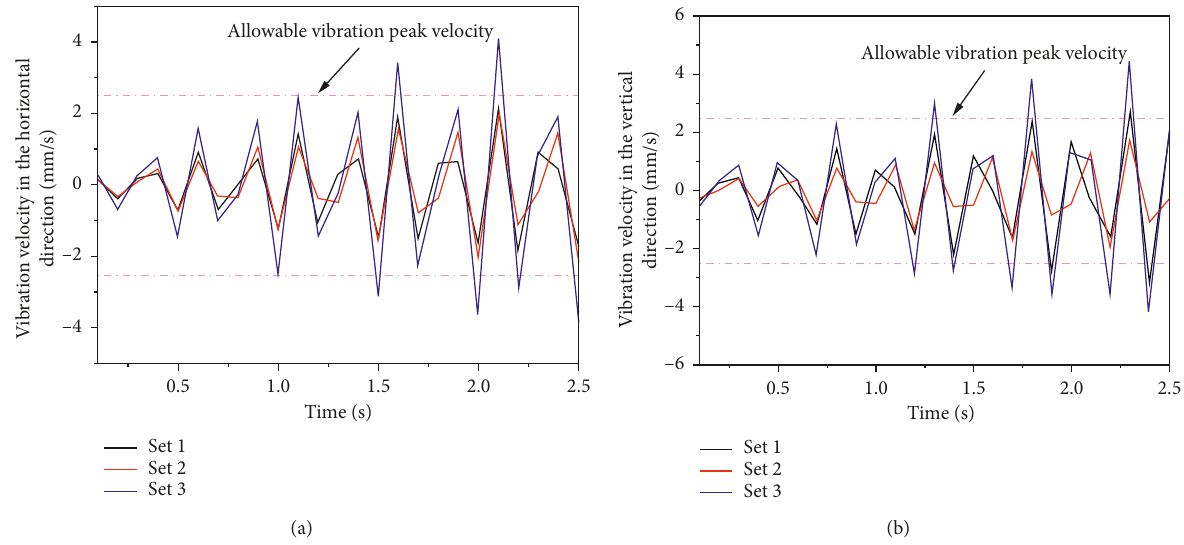
Figure 8: Time history of the vibration velocity of observation point: (a) horizontal direction and (b) vertical direction.